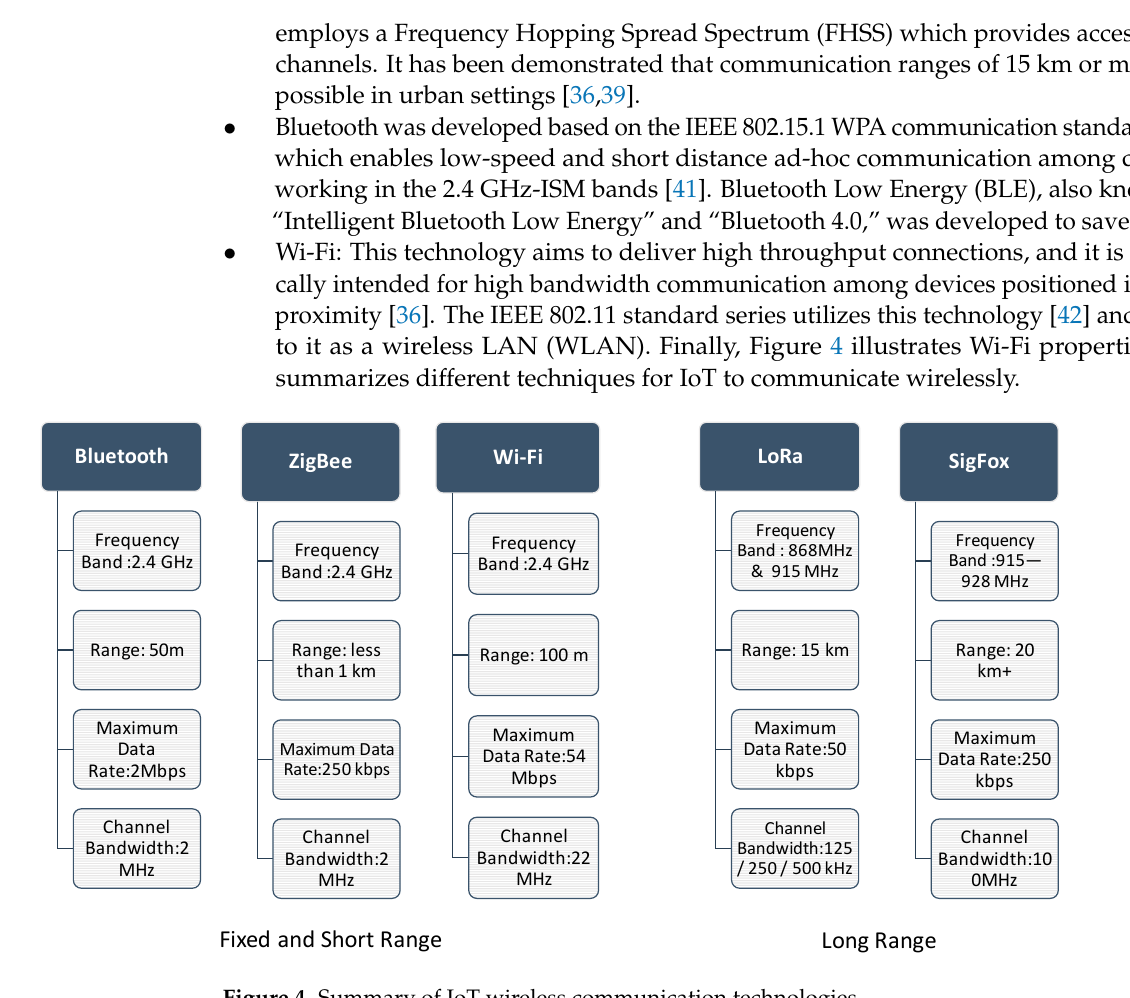
Figure 4. Summary of IoT wireless communication technologies.